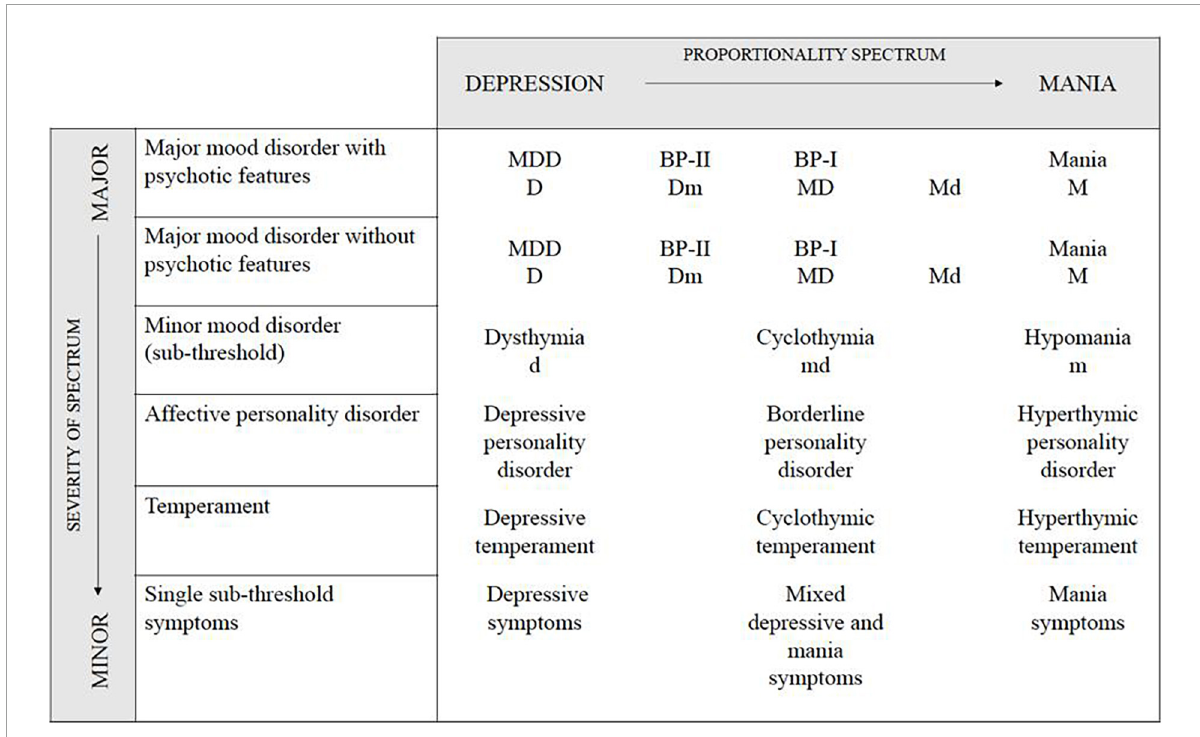
FIGURE1 The concept of two-dimensional affective spectrum based on Angst (10). The horizontal axis represents the first dimension of this model–a continuum of proportional mood spectrum beginning with depression, through three bipolar subgroups, and ending with mania. The second dimension (vertical axis) refers to the severity of symptoms, which range from a major mood disorder, to affective personality disorder, temperament, and finally to single symptoms of bipolarity with severity close to normal. MDD, major depressive disorder; BP-I (MD), bipolar disorder type I; BP-II (Dm), bipolar disorder type II; D, major depression; d, mild depression; M, mania; m, hypomania; Md, mania with mild depression; md, minor bipolar